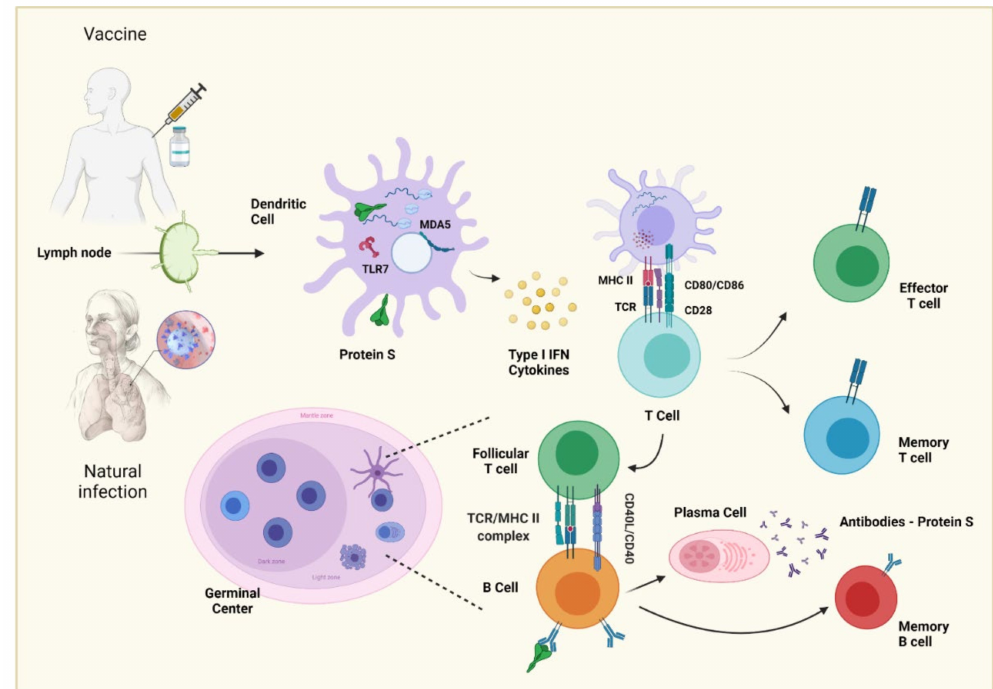
Figure 3. Production of neutralizing antibodies by natural infection/vaccination. The antigen is processed in a dendritic cell to ensure its presentation and to produce cytokines. The dendritic cell within the lymph node presents antigen by class II MHC to naive T-lymphocytes, which differentiate in an effector or memory T-cell. The B cell can recognize native, unprocessed antigens with its BCR, but to perform a more specific response, the antigen needs to enter a germ center to be in contact with a follicular T cell that has already been presented with it, as this allows for it to be presented to the B cell and for the germ center reaction to begin, thereby producing specific antibodies, in this case, those against